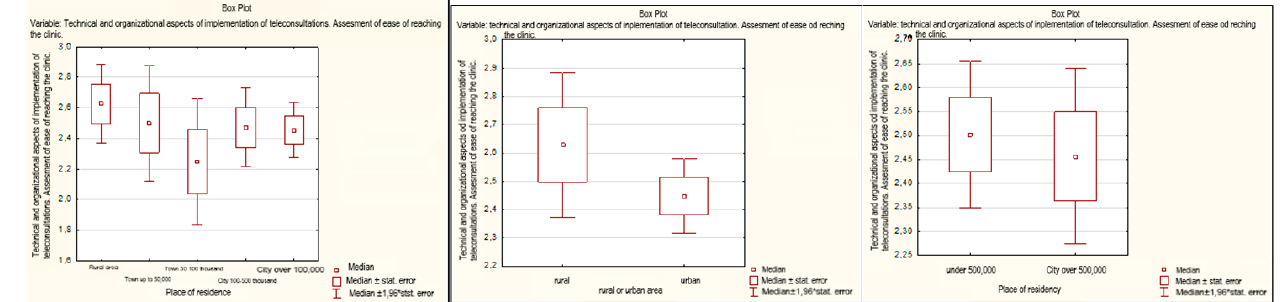
Figure 1. Assessment of ease of getting a call through to a clinic, depending on the place of residence.